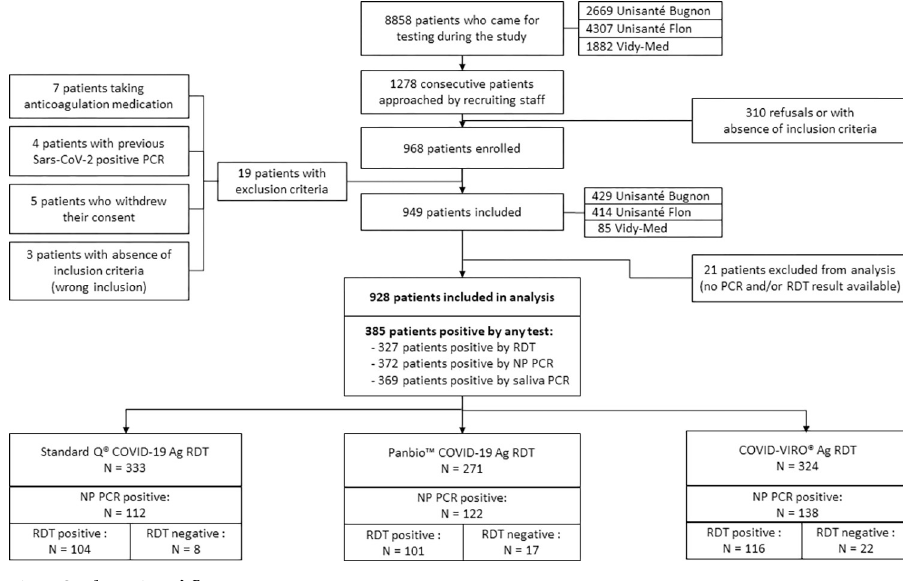
Fig 1. Study patients’